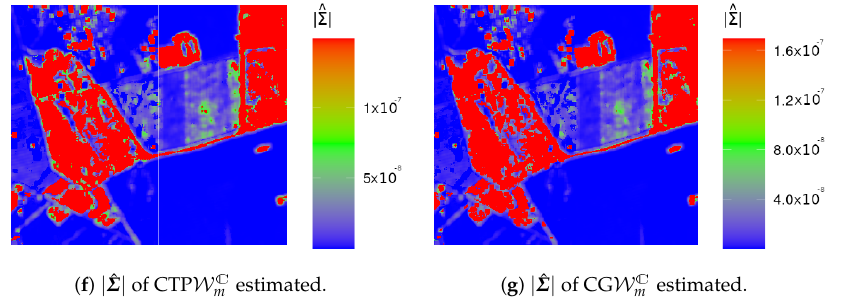
Figure 6. Maps of estimated parameters of Foulum for CTP W C m ( left ) and CG W C m ( right ) distribu- tions, respectively.